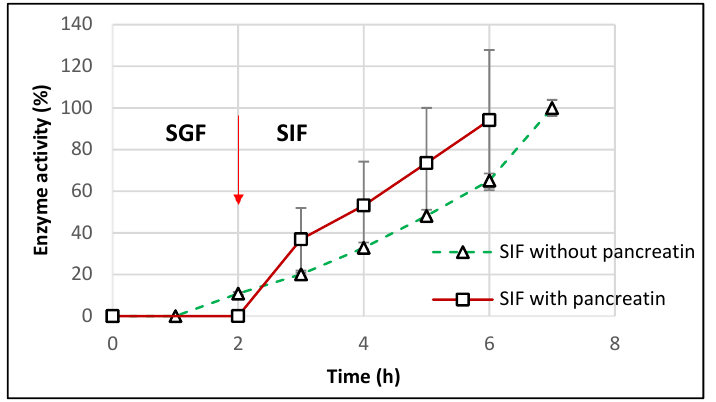
Figure 9. Release profile of catalase from tablets of TMACMS containing 30% CAT in SGF to SIF with and without pancreatin. The arrow marks the transition of the tablets from SGF to SIF.